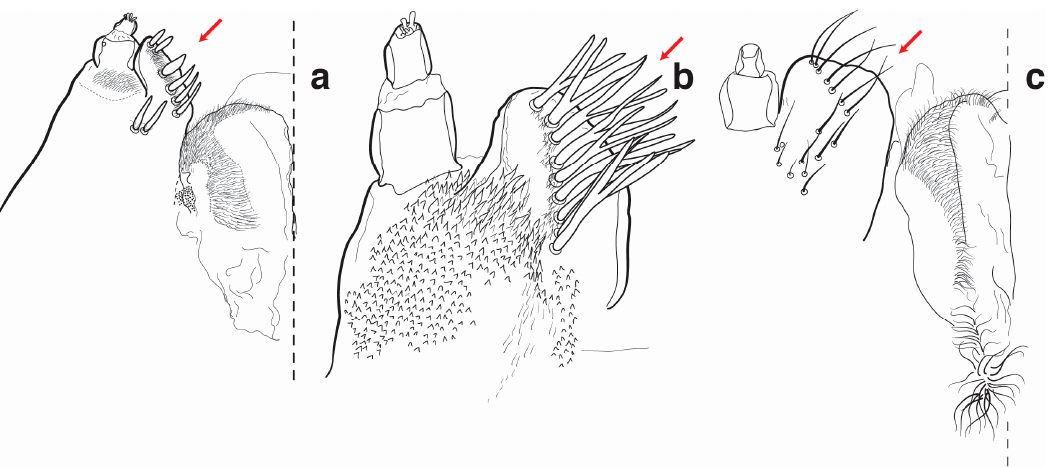
Figure 41. Mala and maxillary palp, larva, dorsal view: ( a ) Cactophagus ; ( b ) Cosmopolites ; and ( c ) Rhynchophorus .